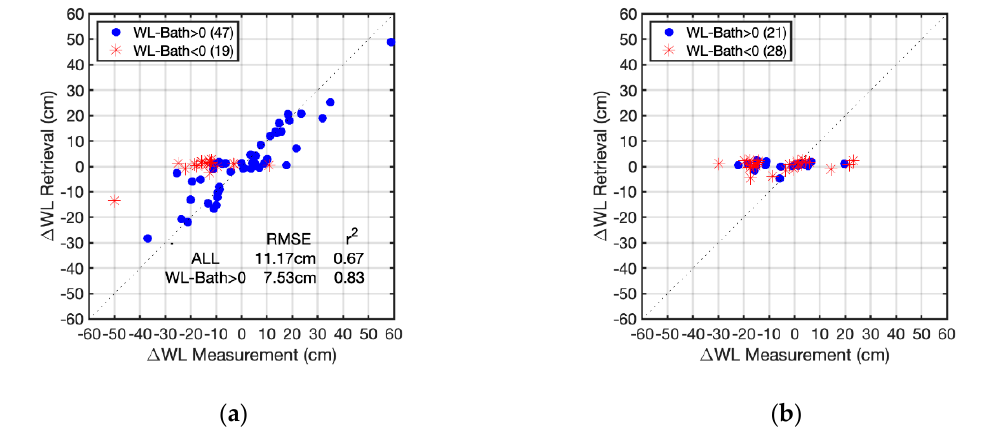
Figure 12. Total scatter plots of water level change retrieval from ( a ) swamp CRMS stations, ( b ) marsh CRMS stations. Bath stands for the wetland elevation from USGS DEM around each CRMS station. WL stands for water level.